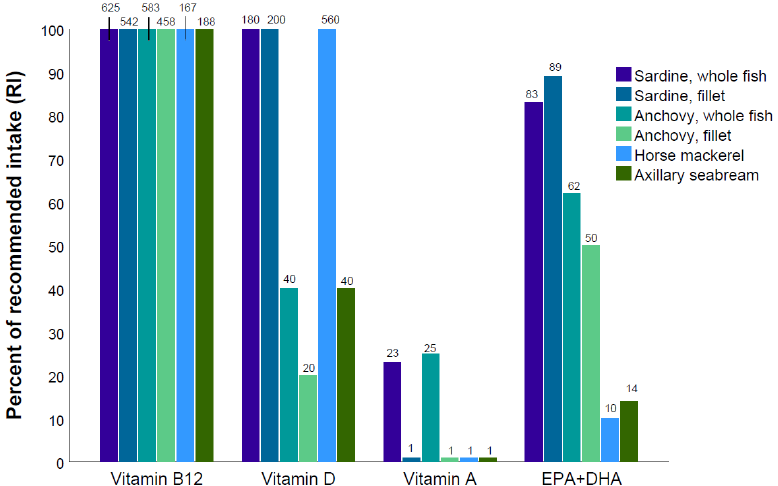
Figure 2. Percent of recommended intake of selected vitamins and EPA + DHA of 100 g of sardine (whole fish and fillet), anchovy (whole fish and fillet), horse mackerel, and axillary seabream sampled from Northwestern African marine ecosystems, May 2017. Recommended Nutrient Intake (RNI) values from WHO are used (WHO, 1998) with the exception of EPA + DHA where the Dietary Reference Values (DRV) from EFSA are used (EFSA, 2010).